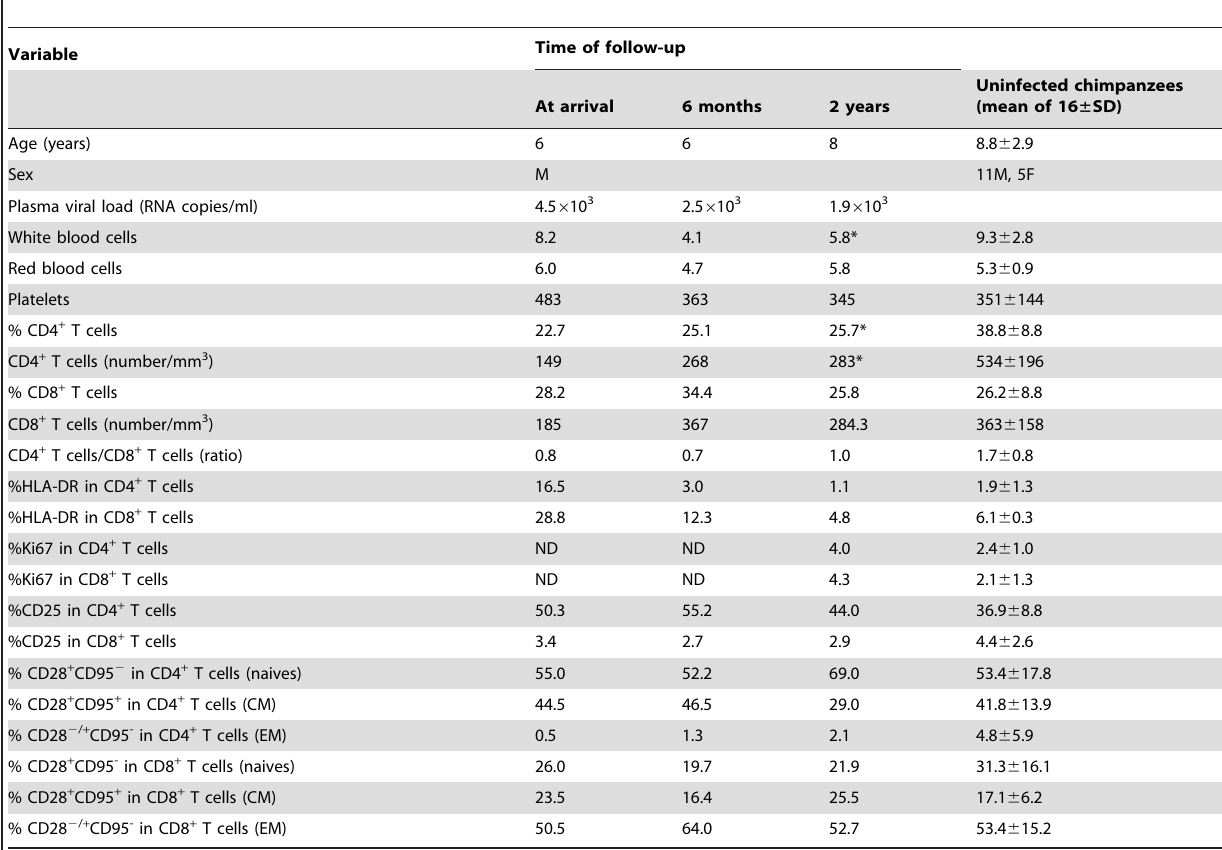
Table 3. Hematologic and immunologic parameters of chimpanzee Gab4 and of 16 uninfected chimpanzees.